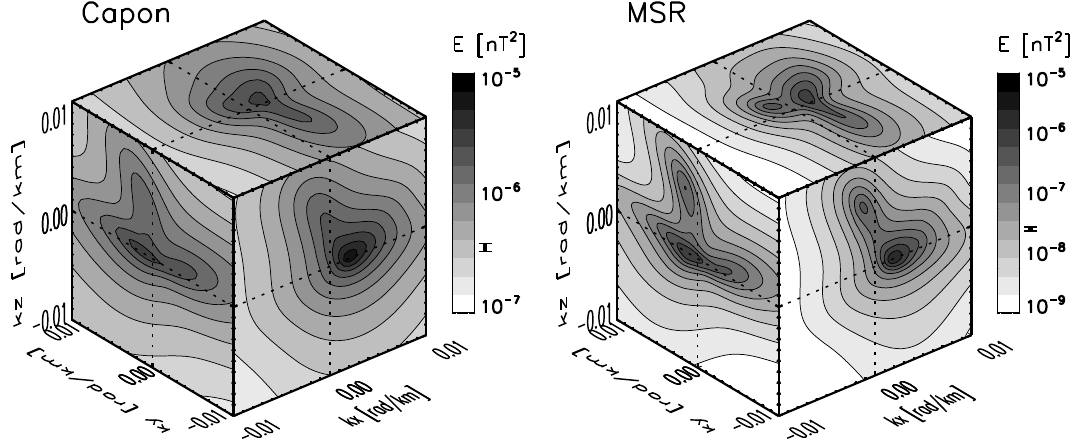
Fig. 9. 3-D energy distributions in the wave vector domain in the mean-field-aligned coordinate system at frequency 0.15Hz, determined by Capon’s method (left) and the MSR technique (right). In this coordinate system the k z -axis (vertical axis) points to the direction of the mean magnetic field, and the k x - k z plane is spanned by the mean field and the flow velocity direction. The 3-D spectrum is represented using projection into 3 planes: it is summed over the wave vector component perpendicular to the respective planes. The vertical bar at color scale represent the 95% confidence interval.